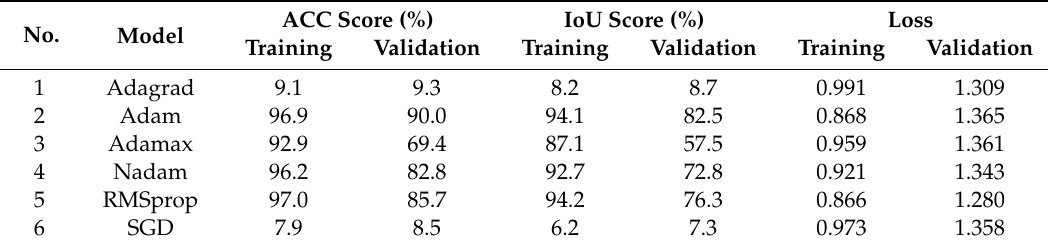
Table 3. Accuracy values for the ResU-Net models using six optimizer functions.